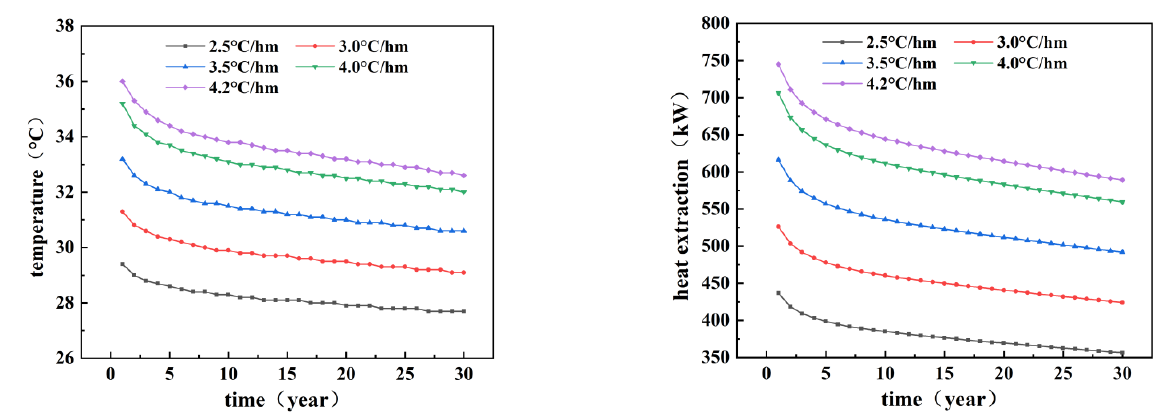
Figure 9. Optimized production temperature and heat extraction for M2 well at different geothermal gradients.